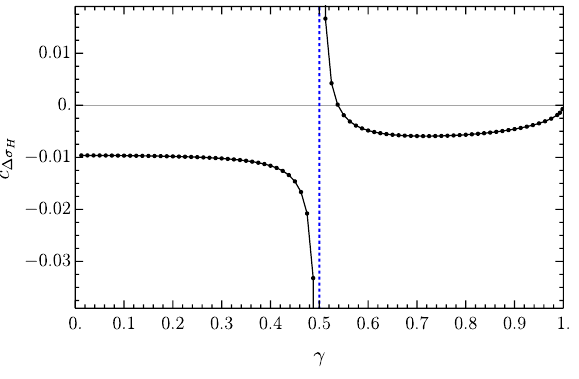
Figure 3 . Coe(cid:14)cient c (cid:1) (cid:27) of the entropy density di(cid:11)erence (cid:1) (cid:27) H (cid:24) c (cid:1) (cid:27) H lattice angle (cid:13) = sin (cid:18) for (cid:13) 6 = 1 = 2. Perturbation theory breaks down at (cid:13) = 1 = 2 and the radius of convergence of our solutions decreases as this critical value is